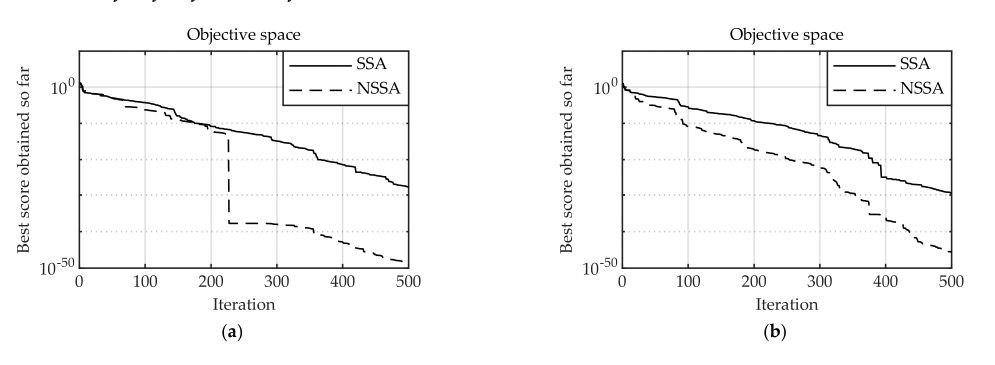
1 ; ( b ) f 8 ; ( c ) f 14 ; ( d ) f 15 .